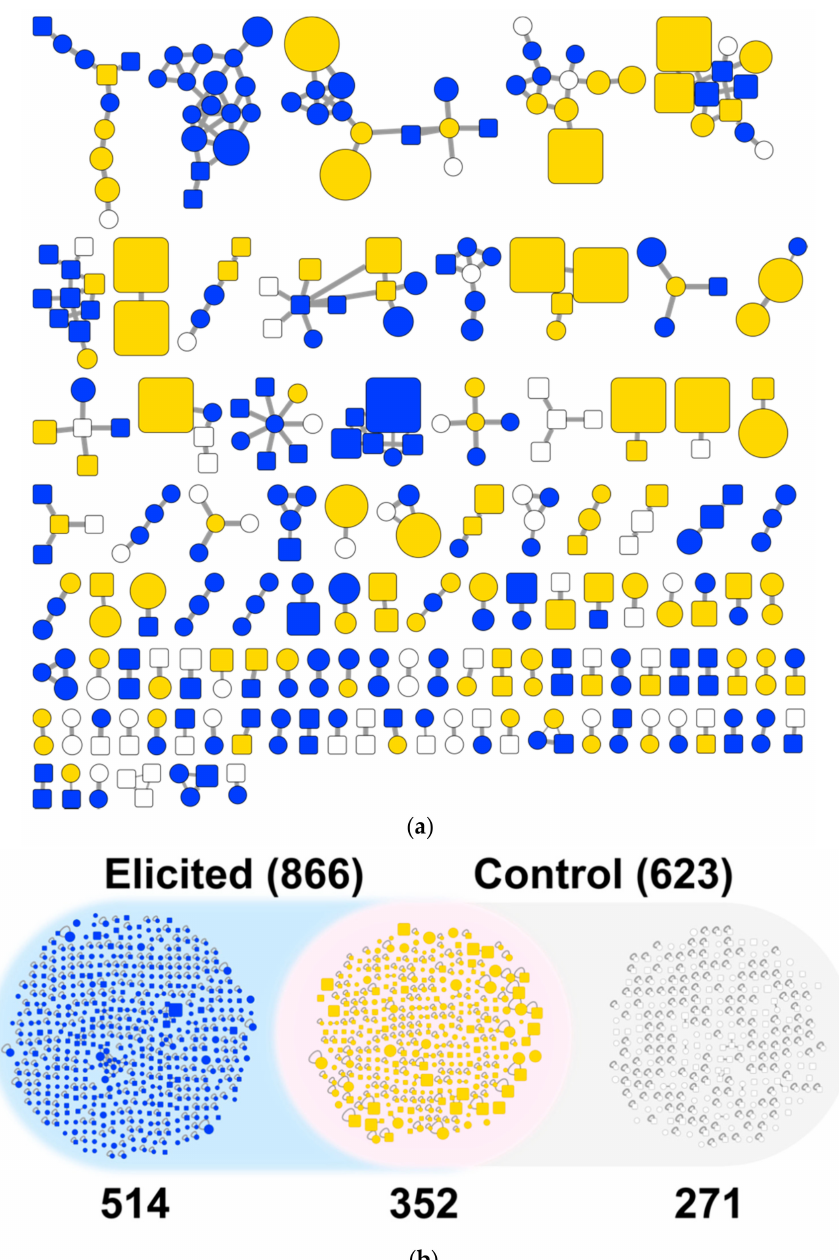
Figure 4. SSMN analysis of the [M + H] + consensus spectra linked to bacterial metabolites detected in the EPfB chemical library shows the increment of chemical diversity promoted by bacterial cultivation in the presence of chemical elicitors. The network nodes (circles and squares) represent the [M + H] + consensus spectra and the links connecting two nodes represent their spectra similarity score, ranging from 0 (totally dissimilar) to 1 (completely identical). The network is organized in spectra clusters by applying a spectra similarity threshold greater or equal to 0.6, limiting the number of neighbors of each node to 15 and limiting the clusters size to 200 nodes. ( a ) Network organization by the size of the spectra clusters, highlighting the larger clusters at the top of the network. The percent of ion contribution (peak area) of each growth condition to each node is denoted by the size of the node. Nodes are colored according to the sample of origin: exclusive to elicited growth conditions (blue), exclusive to control growth conditions (no elicitor added—in white), and common to both elicited and control conditions (yellow). The link’s width is proportional to the spectra similarity value between the two connected nodes. Self-loops (nodes with no connections) were excluded for better visualization. Nodes were further compared to MS/MS databases and annotated. The identified nodes are shown in squares. ( b ) Network organization by grouping the nodes detected preferentially under a given growth condition. Numbers indicate the total number of nodes in each group (including self-loops). The same color code in ( a ) is